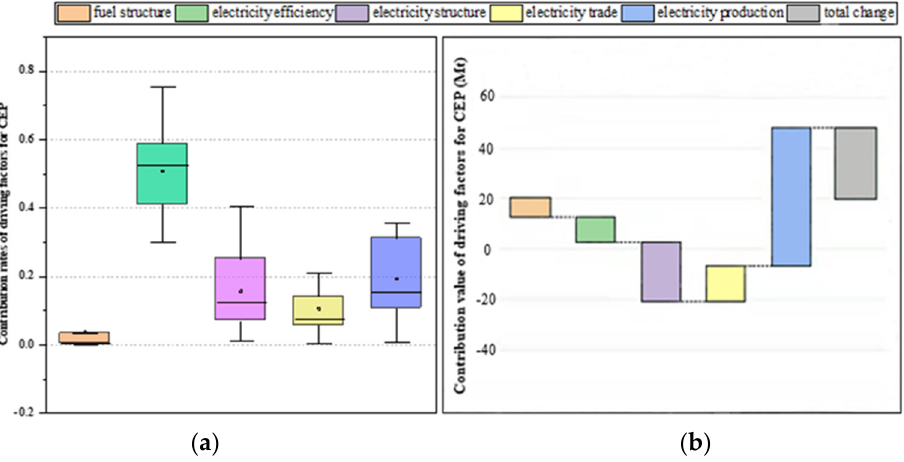
Figure 6. Contribution rates and contribution value of driving factors for CEP. ( a ) Contribution rates of driving factors for CEP. ( b ) Contribution value of driving factors for CEP.